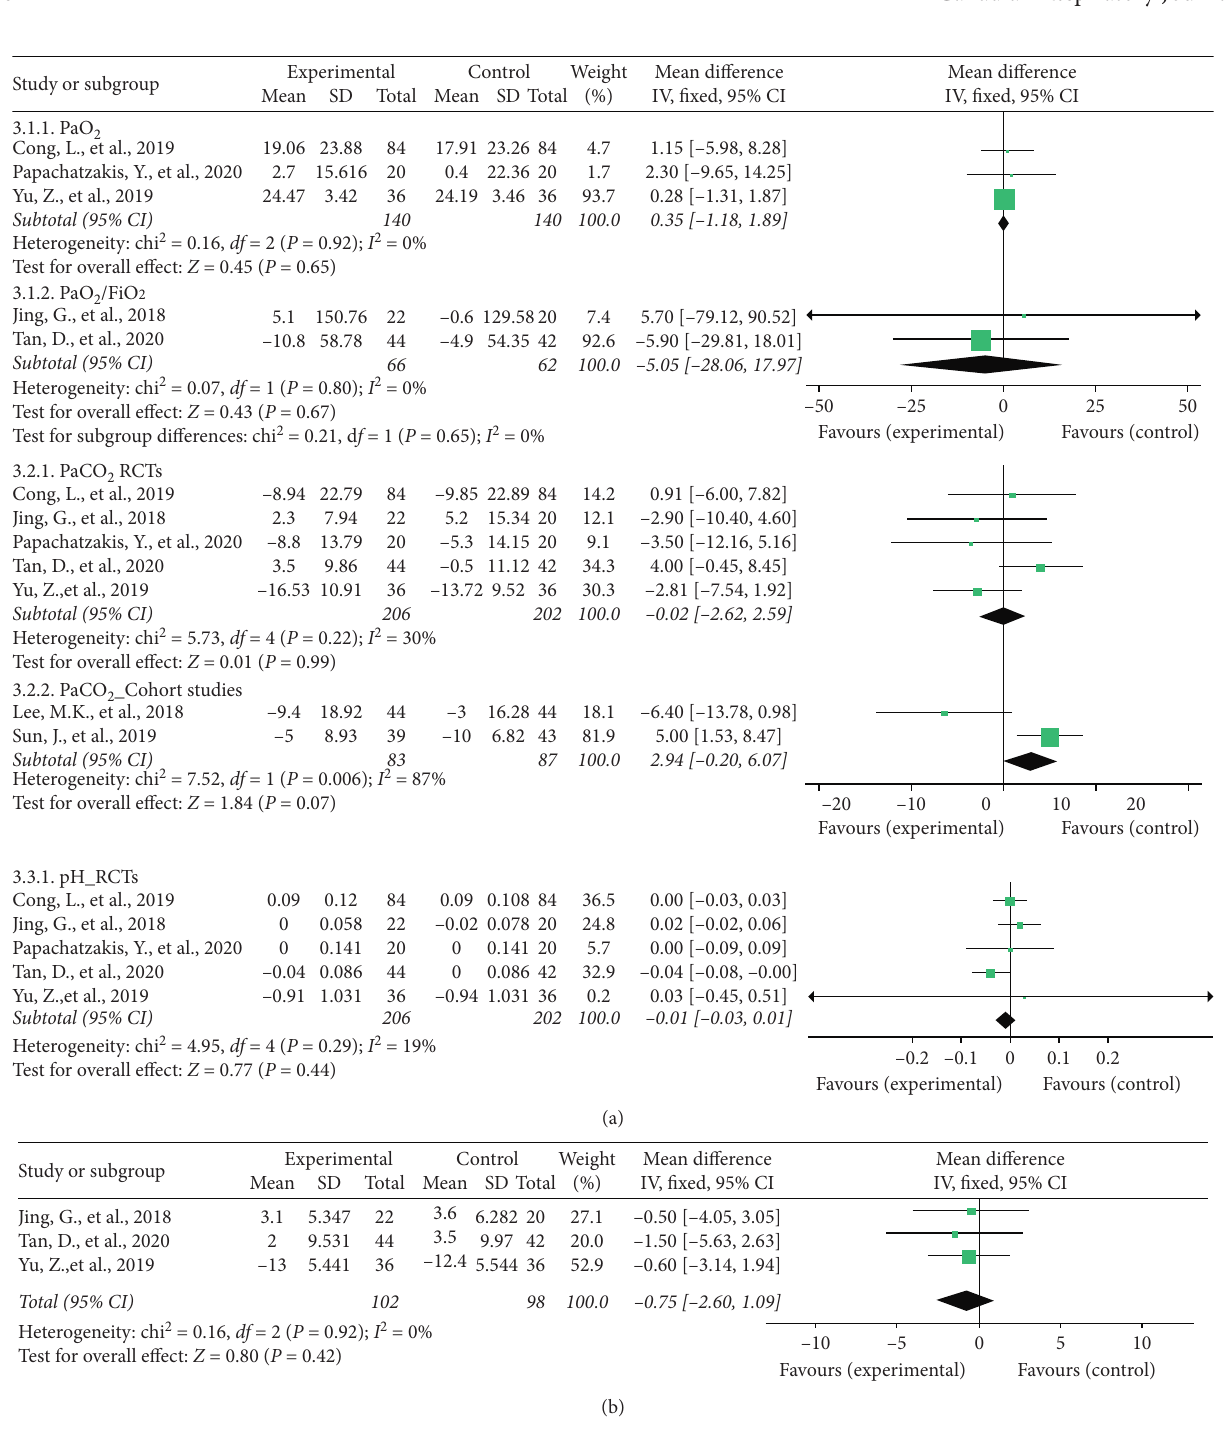
Figure 4: (a) Blood gas analysis. (b) Respiratory